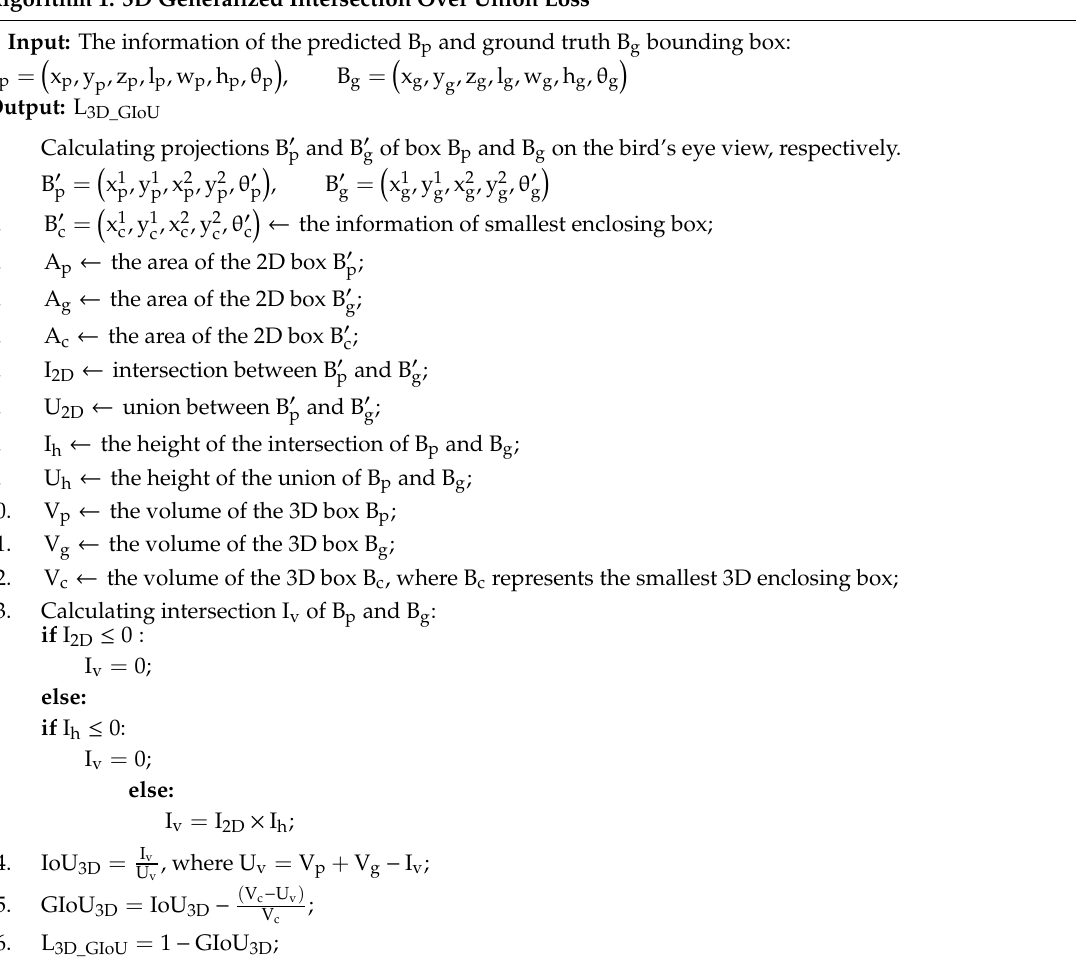
Algorithm 1: 3D Generalized Intersection Over Union Loss